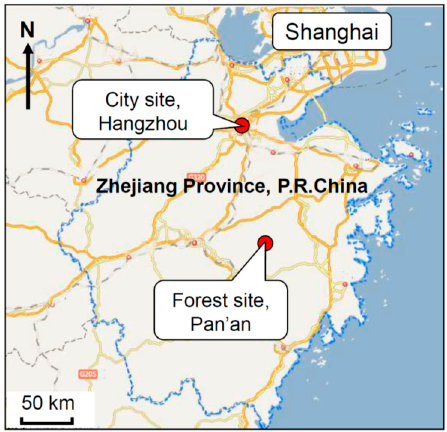
Figure 1. Location of the two experimental sites. Huangtan Forest Park is located in Pan’an County, Zhejiang Province, China. It is about 160 km from the urban experimental site, which is situated in the downtown area of Hangzhou, a city near Shanghai.